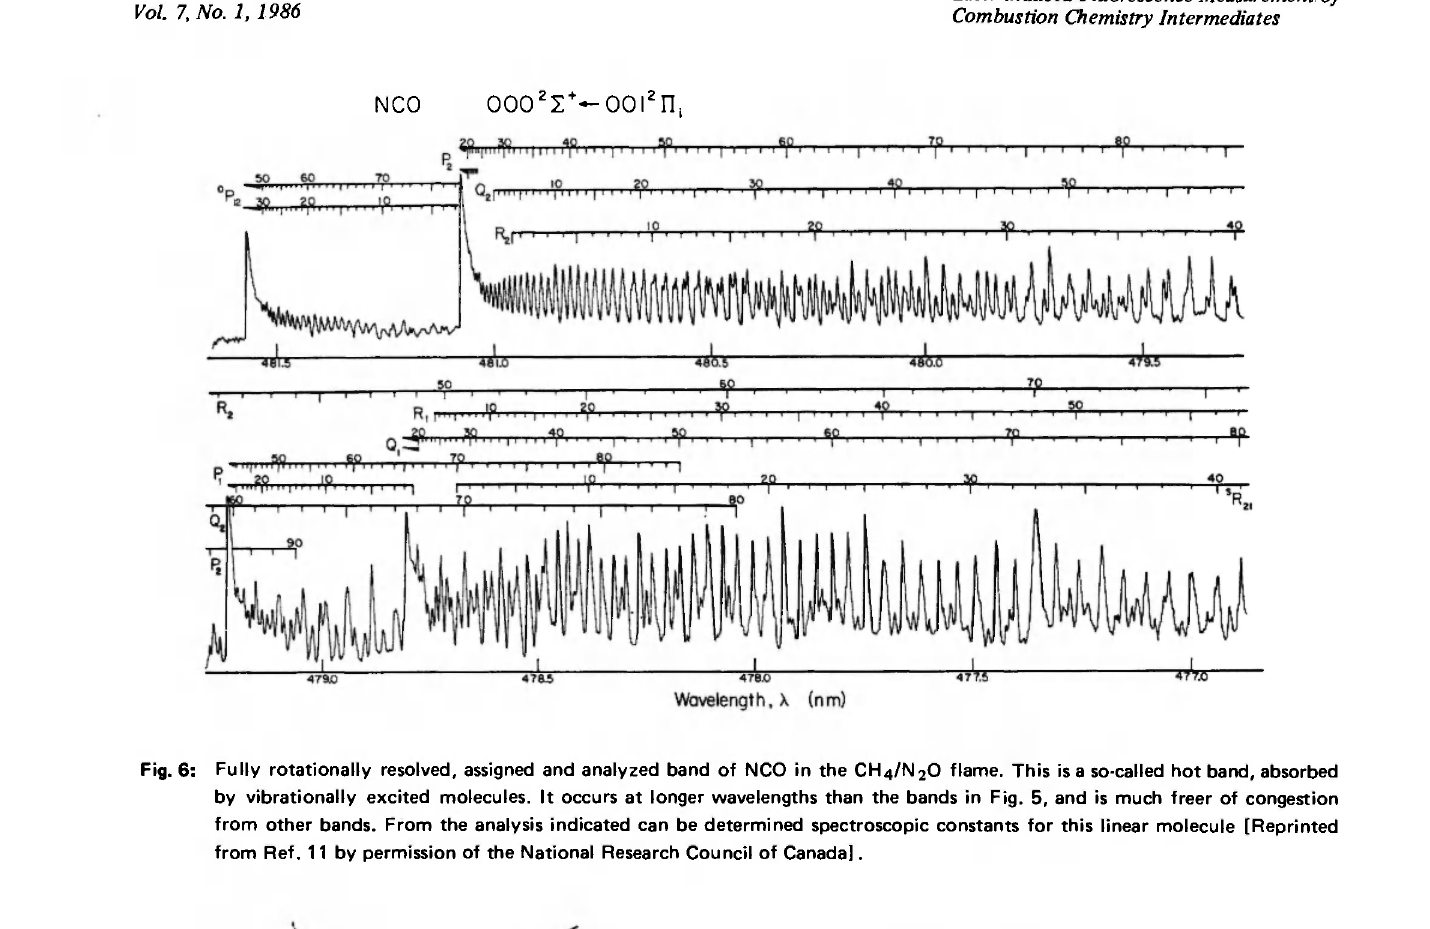
Fig. 6: Fully rotationally resolved, assigned and analyzed band of NCO in the CH4/N2O flame. This is a so-called hot band, absorbed by vibrationally excited molecules. It occurs at longer wavelengths than the bands in Fig. 5, and is much freer of congestion from other bands. From the analysis indicated can be determined spectroscopic constants for this linear molecule [Reprinted from Ref. 11 by permission of the National Research Council of Canada].